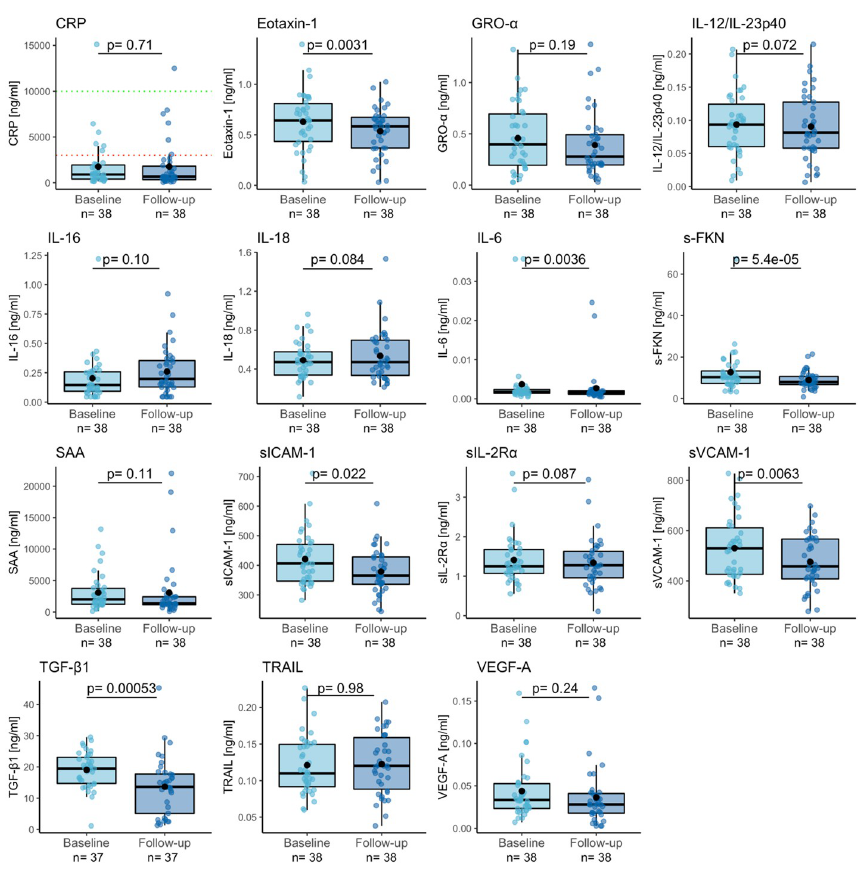
Fig 1. Exercise is associated with a reduction in sFKN, TGF- β 1, eotaxin-1 and IL-6. The differences in plasma inflammatory biomarker levels between baseline and follow-up (i.e., before and after the 12-week physical exercise intervention program), were determined using Wilcoxon signed-rank tests. For CRP, the dotted red (3000 ng/ml) and the dotted green (10 000 ng/ml) lines represent the cut-offs for low-grade and mild-acute inflammation,